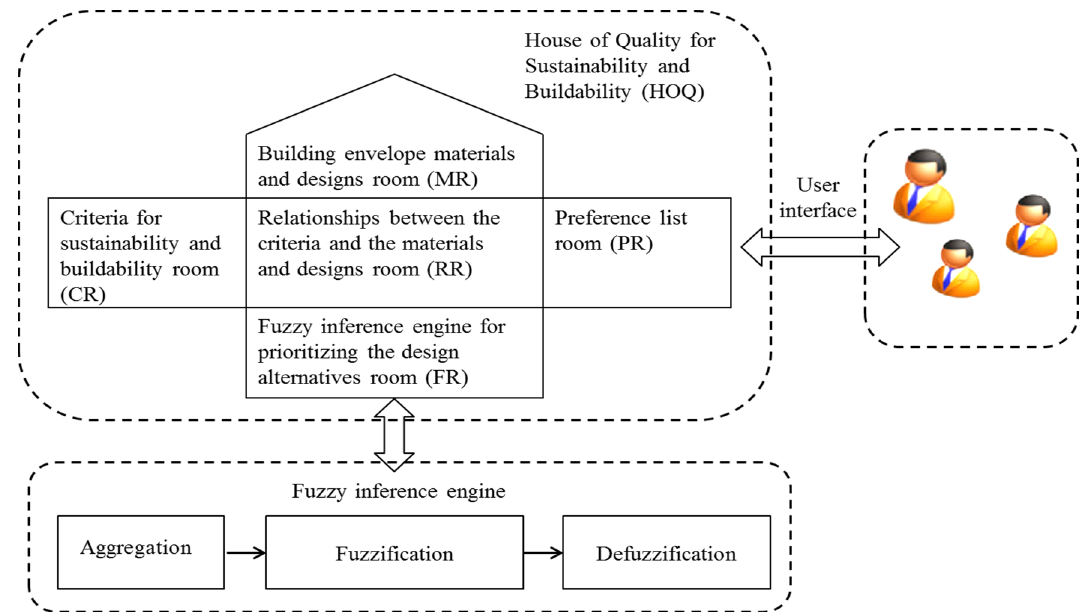
Figure 1. House of Quality for Sustainability and Buildabilty